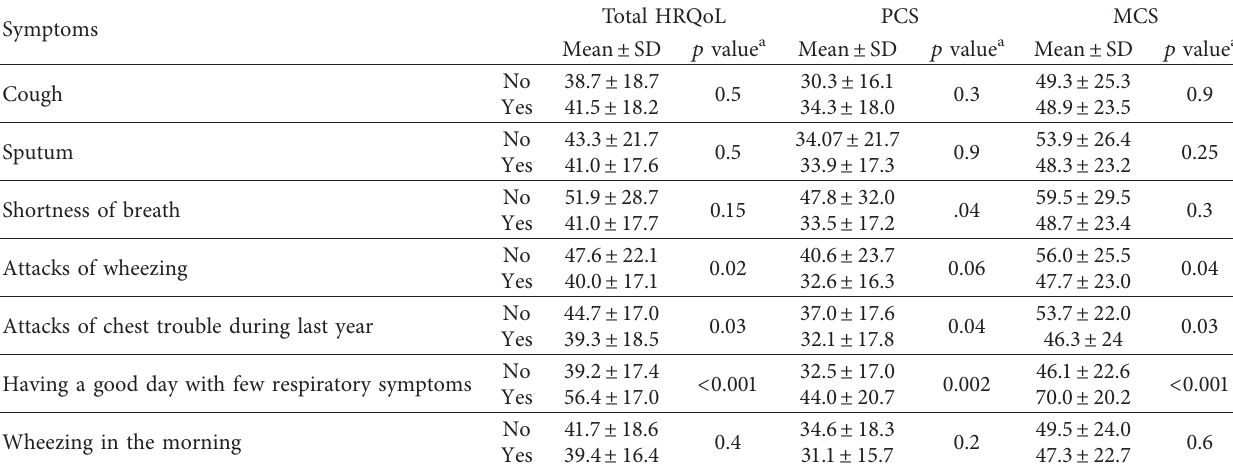
Table 2: HRQoL and experienced respiratory symptoms in elderly patients with